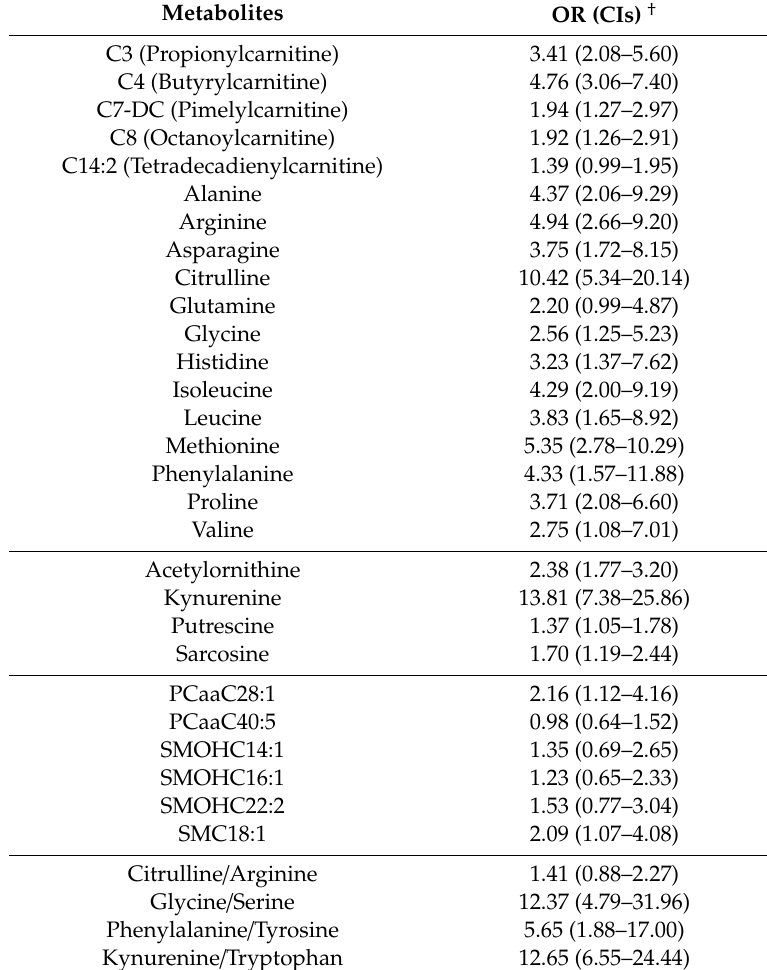
Table 3. Association (odds ratio, OR) and 95% confidence intervals (CIs) between metabolites and CKD